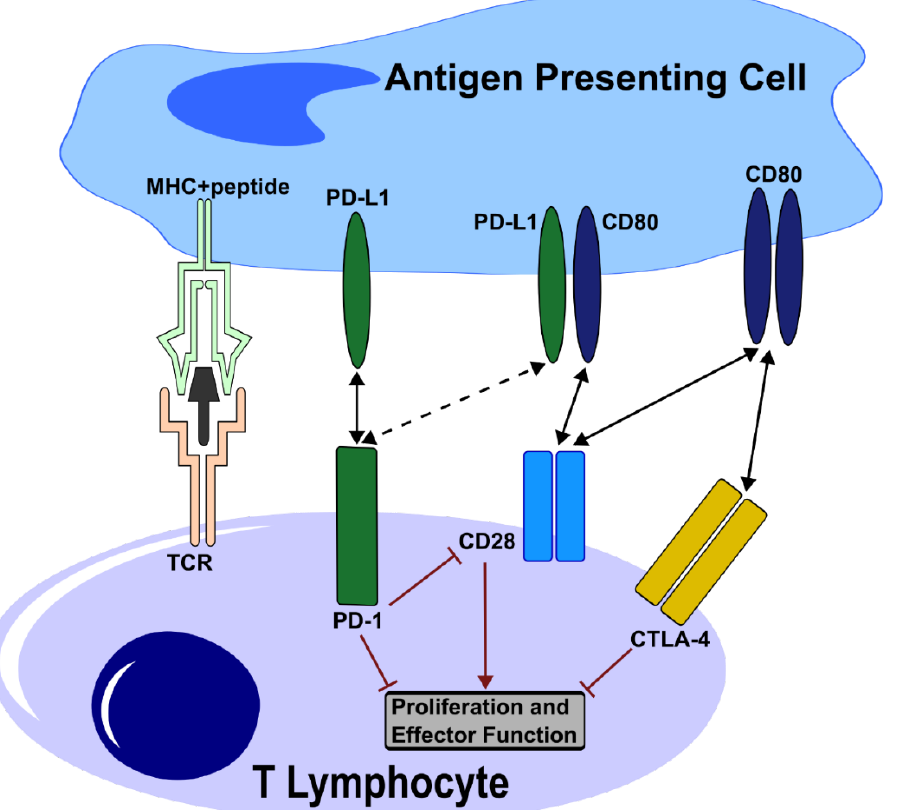
Figure 1. Inactivation of T-cell function through PD-L1 mediated blockage: In parallel to the activation of the TCR, PD-L1 engages PD-1, which delivers an inhibitory signal into the T cell. PD-L1 can also bind CD80 in cis, forming a heterodimer and dissolving the CD80 homodimer. This prevents the CD80 – CTLA-4 interaction, while preserving CD28 binding capabilities. PD-1 – PD-L1 interaction activates PD-1, leading to the dephosphorylation of CD28 and preventing T-cell co-stimulation through CD28. Black arrows depict an interaction between proteins, whereas the red hammers and arrows indicate an inhibitory and an activating effect, respectively.